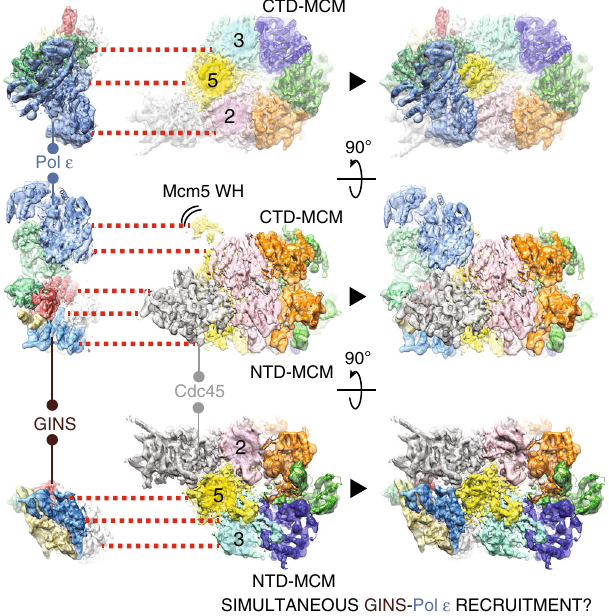
Fig. 8 Proposed mechanism for the concomitant recruitment of GINS and Pol epsilon onto MCM. By interacting with Cdc45 on the N-terminal MCM face, GINS stabilizes the Mcm2-5-3 N-terminal interactions. C-Pol2 and Dpb2 in the Pol epsilon complex play a similar role, by stabilizing the Mcm2-5-3 AAA + ATPase interactions. Given that GINS and Pol epsilon are recruited onto MCM as part of the same complex, concomitant biding of both factors might promote activating conformational changes in the helicase, eventually leading to origin